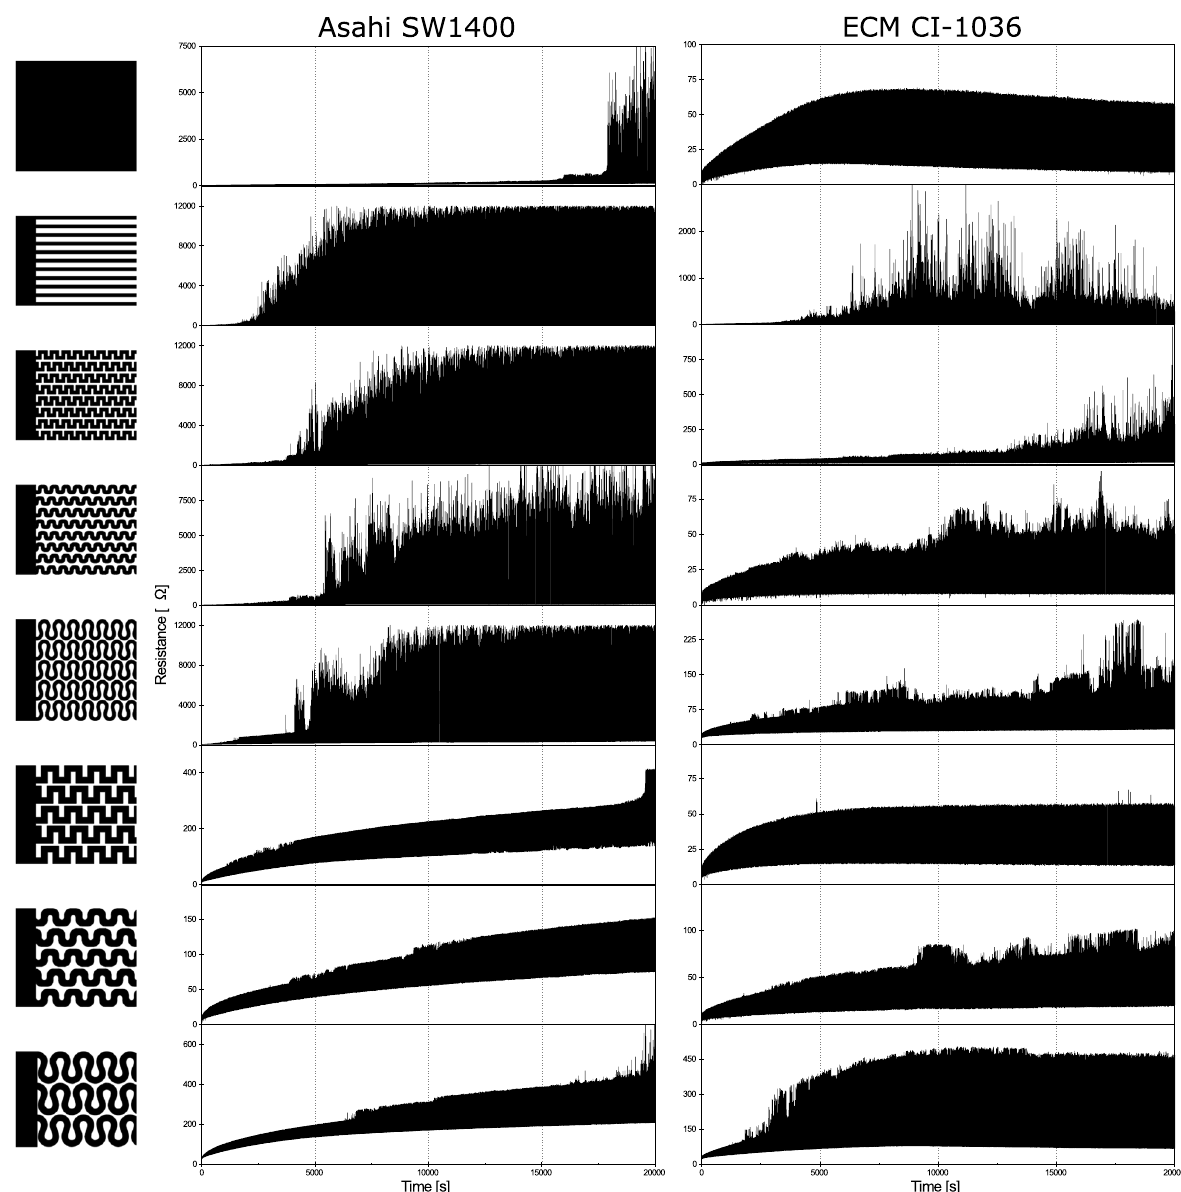
Fig. 3 The resistance of various shaped electrodes for two best-performing pastes. The plots depict the change of resistance during the elongation and relaxation cycle. The full cycle consisted of 10,000, 10% elongation cycles, at speed 0.5 Hz. The resistance axis scale varies, and it is adapted to each resistance range to illustrate the behavior of the electrodes better. The plots for the remaining pastes (ECM CI-4040 and XCMB-590) are available in the Supplementary Supplementary Figures S6 and S7 show that the cracks in the small pattern electrodes range from 4 to 5 µm, while, in the large pattern electrodes, the cracks are from 1 to 2 µm, at the same level of elongation. Regarding the impact of the pattern shape on electrode performance, as in the resistance measurements, the SEMs images do not indicate signi fi cant differences.